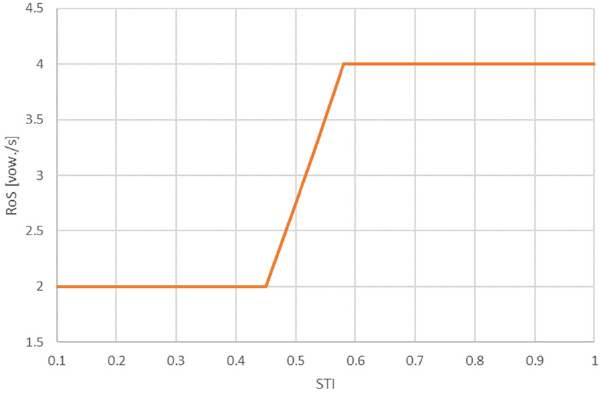
Figure 6. Simplified curve showing RoS values as a function of the STI. Table 7. Proposed RoS values for both curves.